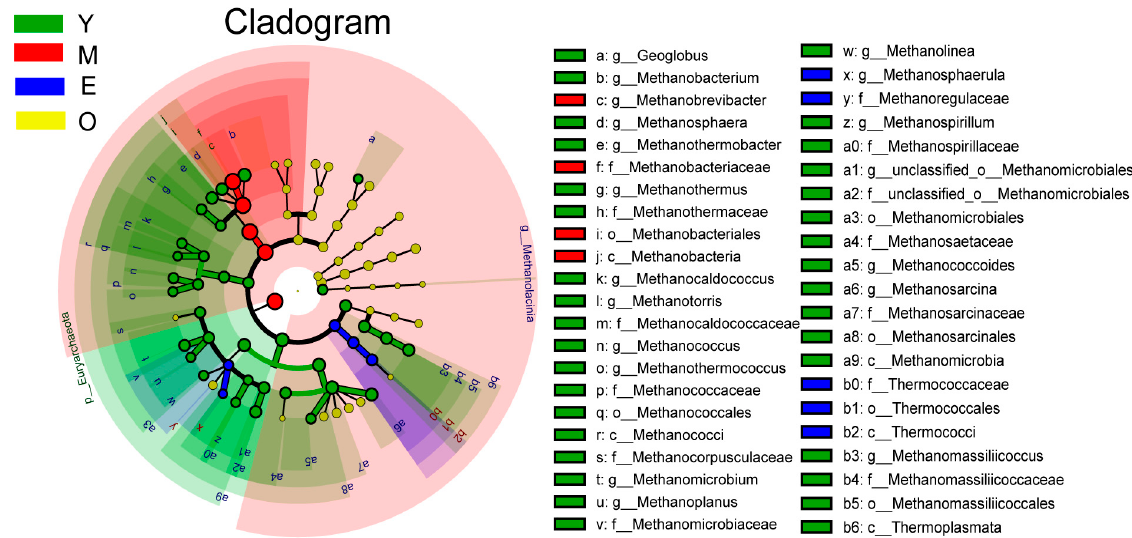
Figure 2. The dairy buffalo rumen archaea showing different abundance values among four groups (highlighted by small circles and by shading). There are five layers from the inside of this plot to the outside, corresponding to five levels of taxonomy (phylum, class, order, family, and genus). The nodes (small circle) with different colors represent archaeal characteristics of the corresponding groups with the higher abundance compared with that in the other three groups, while yellow nodes indicate the bacteria that are not statistically and biologically differentially abundant among the four groups. Significant differences were confirmed by linear discriminant analysis effect size (LEfSe) analysis with the cutoff of LDA > 3 and p < 0.05.